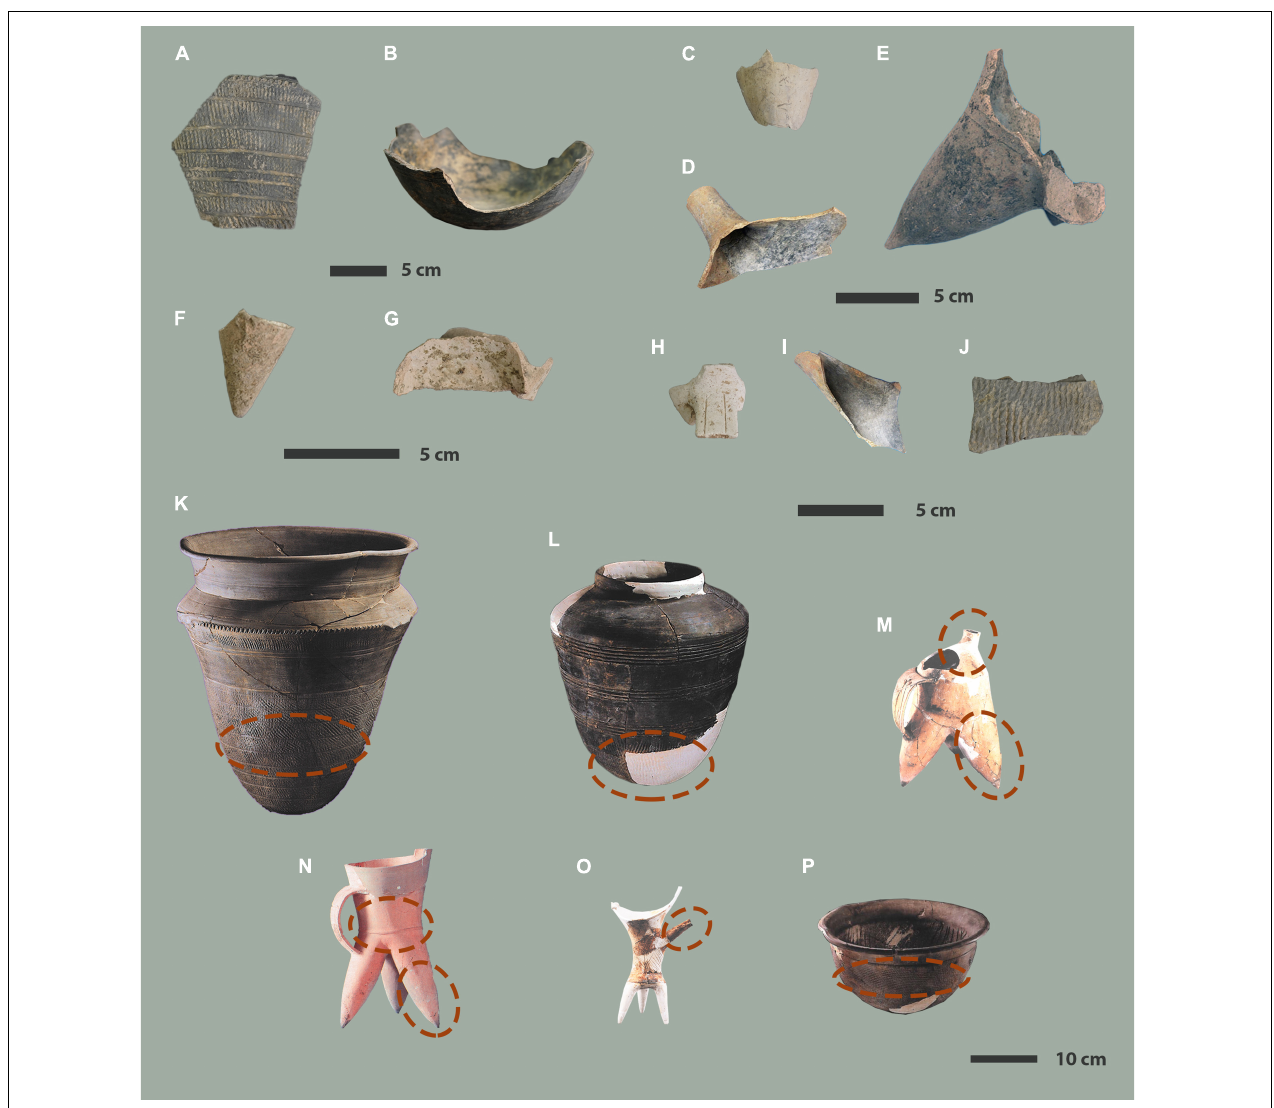
FIGURE 2 | Selected pottery sherds analyzed (A–J) and corresponding complete vessels (J–O) . (A) Dakouzun Urn, body; (B) zun Jar2, base; (C) he Pitcher1, spout; (D) he Pitcher4, spout; (E) he Pitcher5, foot; (F) gui Pitcher1, foot; (G) gui Pitcher3, body; (H) jue Cup1, body; (I) jue Cup2, spout; (J) kecaopen grooved basin, body; (K) dakouzun urn (2001VH272:19); (L) zun jar (2001VH12:7); (M) he pitcher (2002VM4:6); (N) gui pitcher (82YLIX M10:6); (O) jue cup (2001VM1:10); (P) 2002VH87:18 (circles indicate the vessel parts corresponding to the sherds analyzed).